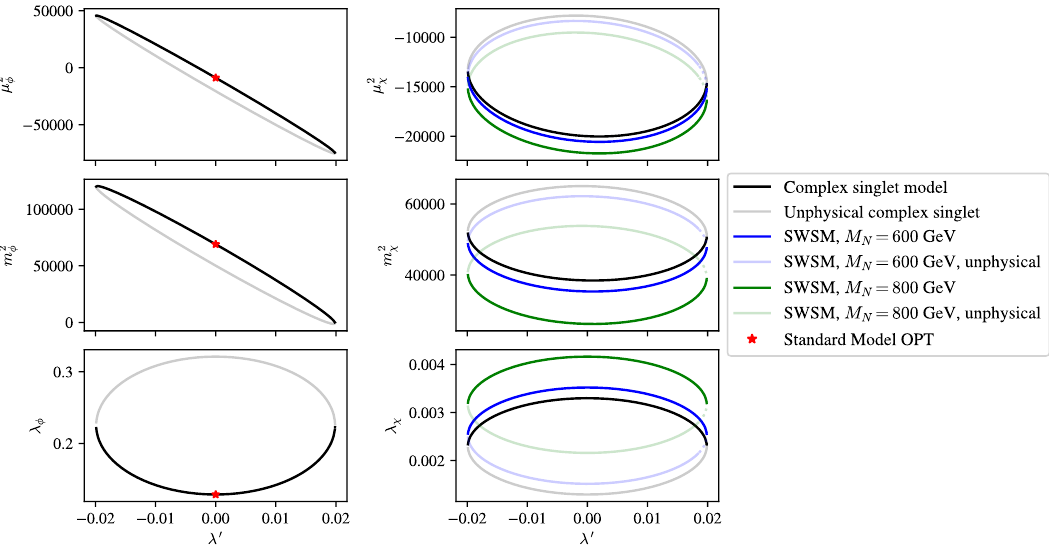
Figure 6 . Parametrization of the SWSM in the OPT scheme. We used w 0 = 10 v 0 , M s = 200 GeV, and Q = M t and for simplicity we set y N = y N . Only heavy RHNs are shown, as lighter ones 2 3 do not significantly alter the parameter values. On the SM side (left panels) the parameters are unaffected by changing the RHN masses and only the M N = 0 plot is shown, i.e., when the SWSM effective potential reduces to the complex singlet